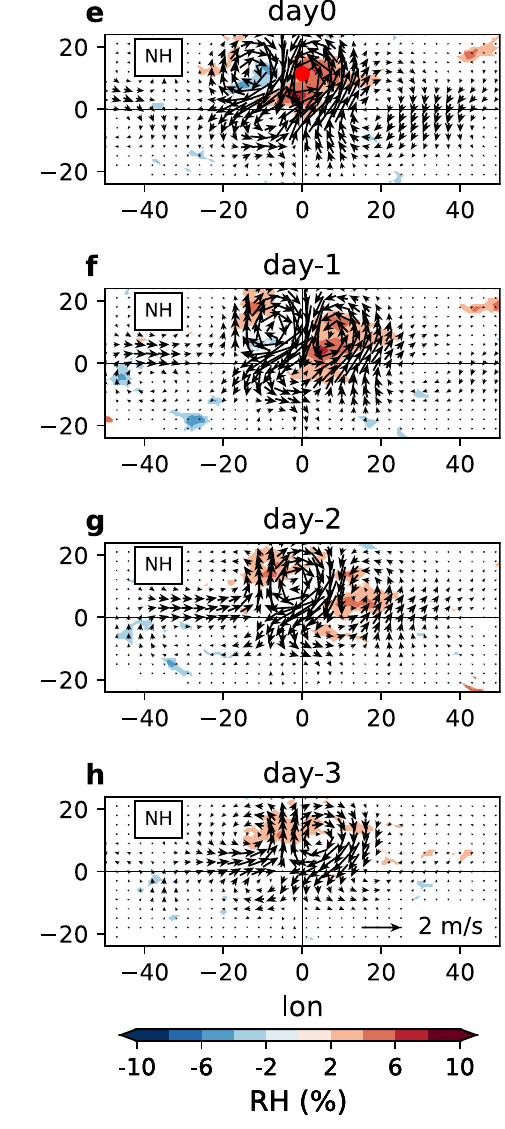
Fig. 4 | Co-existing and pre-existing equatorial waves related to pre-tropical cyclogenesis (pre-TCG) events in the Northern Hemisphere (NH). a Composite means of combined wave horizontal winds (vectors) and relative vorticity (RV, in theunitsof10 − 6 s − 1 ;shading)inthelowertroposphereontopre-TCGeventsthatare simultaneouslymatchedin-phasetoWestward-movingMixedRossby-Gravitywave (WMRG),modenumber1 Rossby wave (R1)and modenumber 2Rossby wave (R2), with respect to the vortex longitude and event time of pre-TCG, in the NH. Only